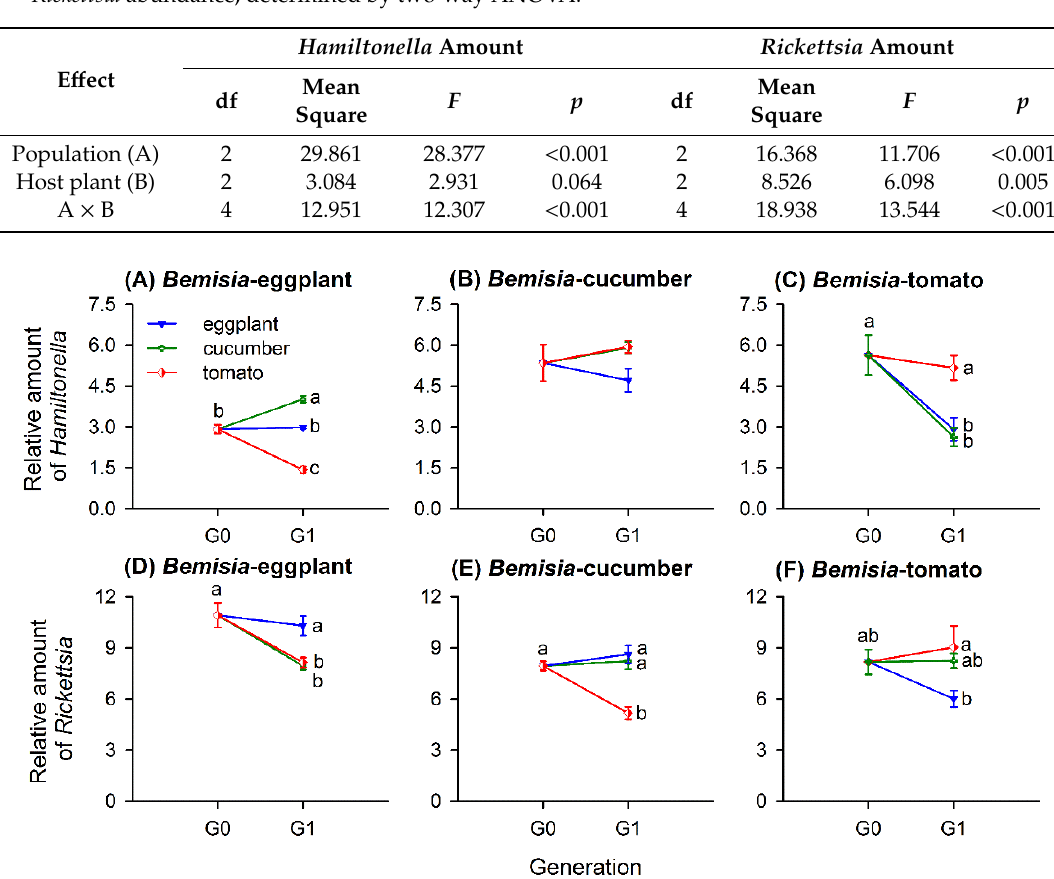
Figure 4. Relative amounts of Hamiltonella and Rickettsia (mean ± SE) in whitefly populations of Bemisia -eggplants ( A , D ), Bemisia -cucumbers ( B , E ), and Bemisia -tomatoes ( C , F ) transferred to natal and two novel host-plant species for one generation. The relative amounts of each symbiont taxon were normalized using β-actin and calculated by the 2 -Δ C t method. Different lowercase letters around the error bars of each whitefly population indicate significant difference of Hamiltonella or Rickettsia when transferred to different plant species ( p < 0.05, Tukey’s HSD test).